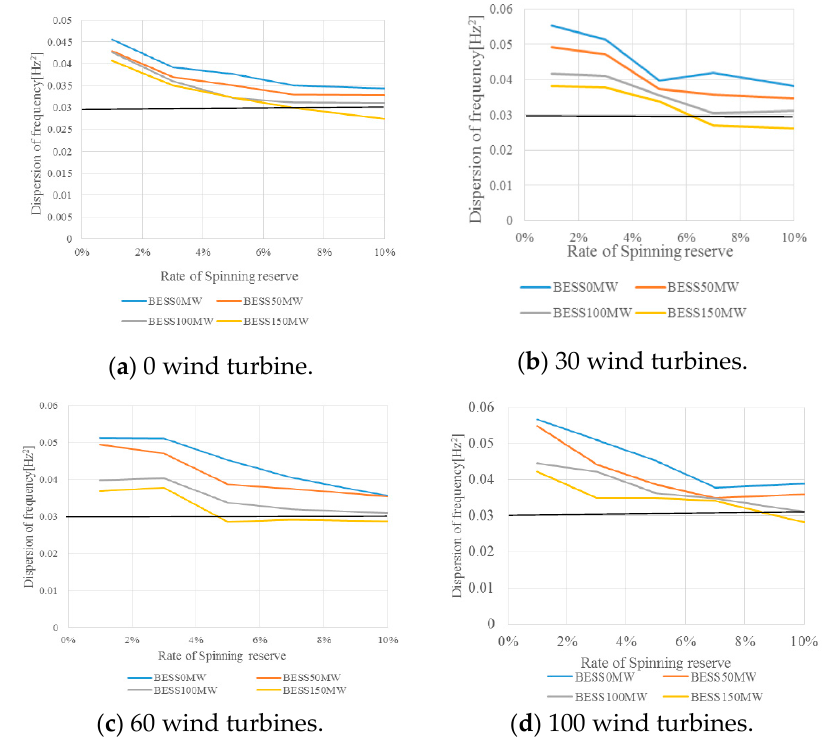
Figure 12. Rate of dispersion under ±1 of 5.7 m/s wind turbine.